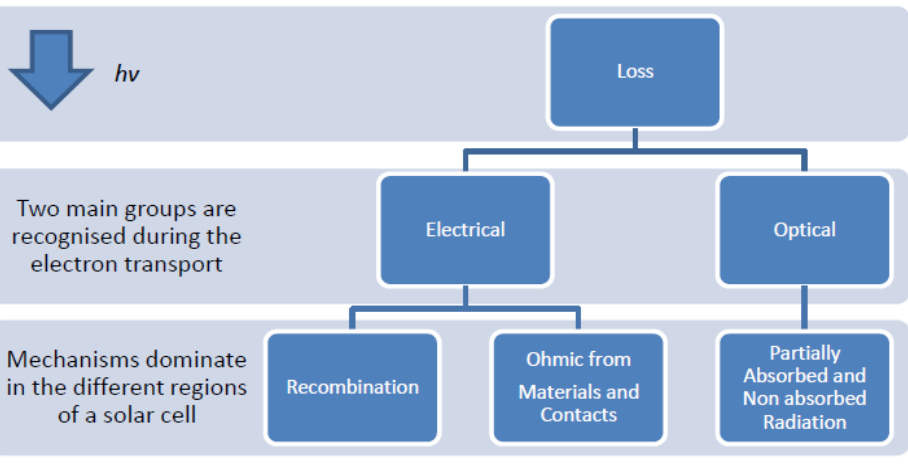
Figure 2. Main photon to charge loss